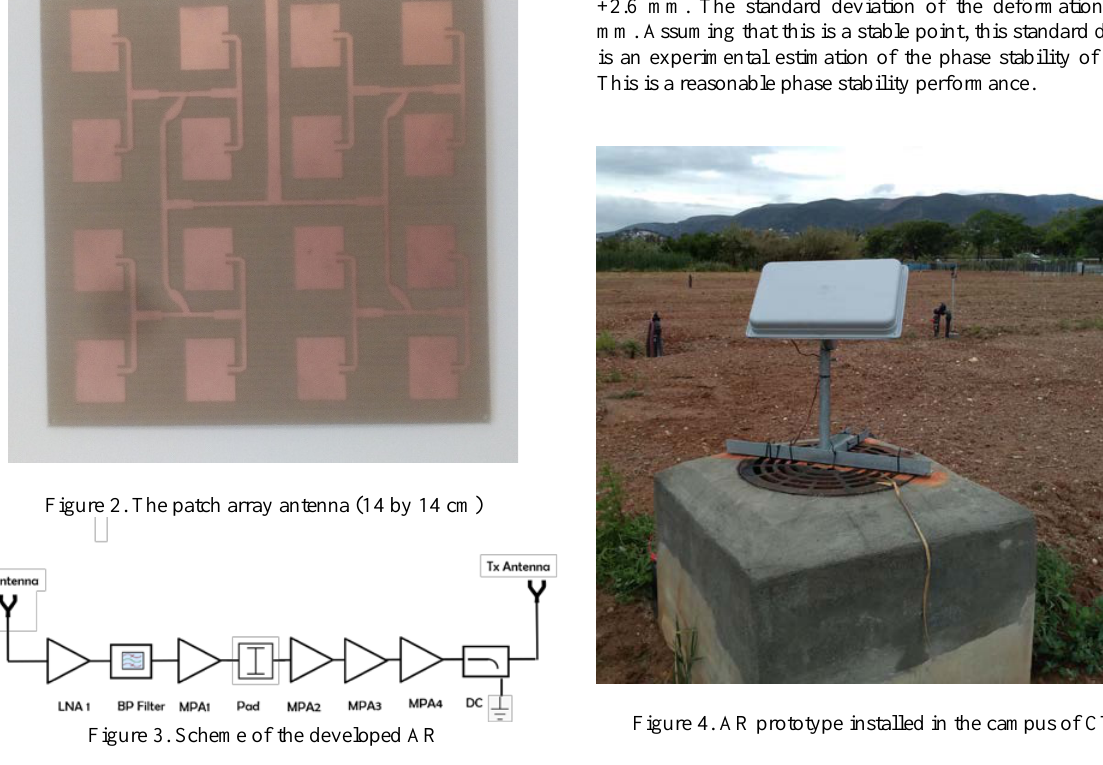
Figure 3. Scheme of the developed AR